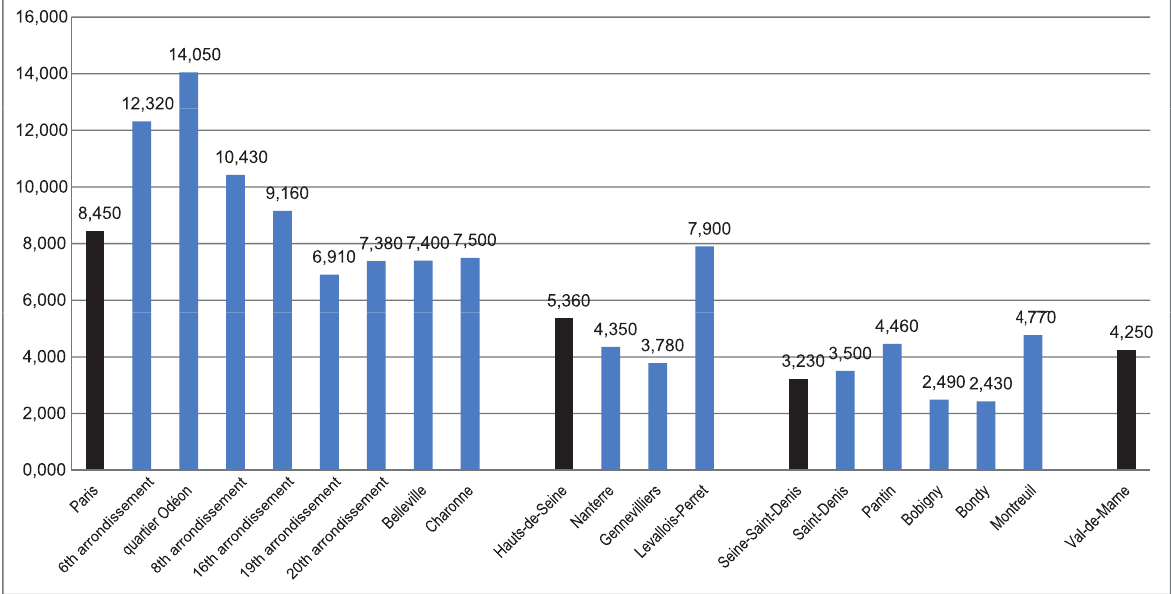
Fig. 3. Average real-estate price per sq. m. across Greater Paris (in €; first quarter 2017). Source: